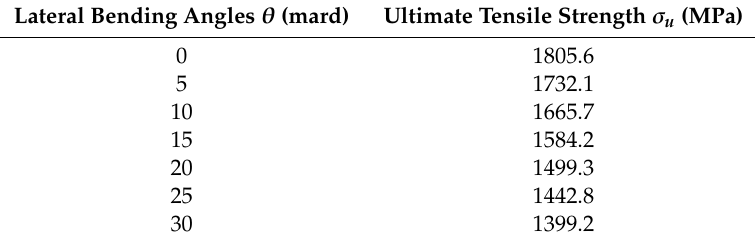
Table 1. The ultimate tensile strengths of the seven-wire strands at di ff erent lateral bending angles by finite element analysis.